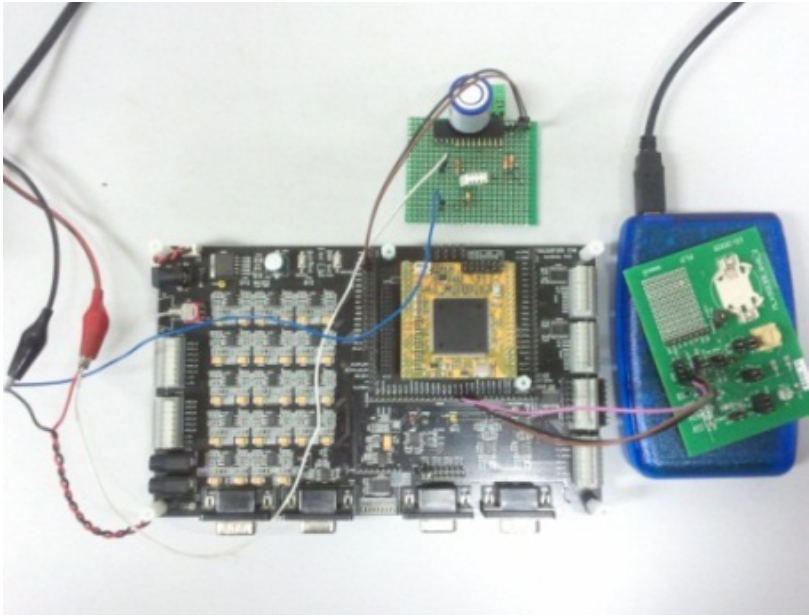
Figure 8. Configuration of the system for experiments.